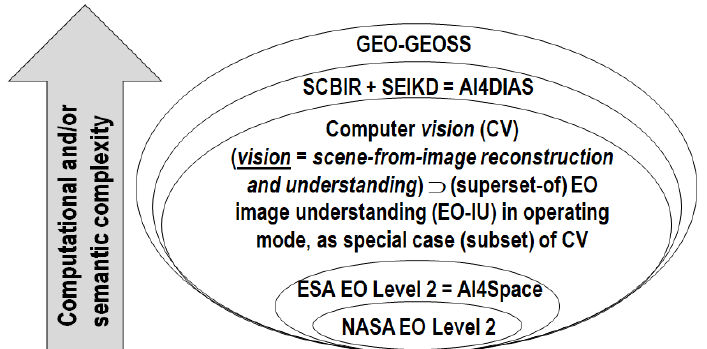
Figure 4. In agreement with the standard Unified Modeling Language (UML) for graphical modeling of object-oriented software [86], relationship part-of , denoted with symbol ‘ → ’ pointing from the supplier to the client, should not to be confused with relationship subset-of , ‘ ⊃ ’, meaning specialization with inheritance from the superset to the subset. A National Aeronautics and Space Administration (NASA) EO Level 2 product is defined as “a data-derived geophysical variable at the same resolution and location as Level 1 source data” [109]. Herein, it is considered part-of an ESA EO Level 2 product defined as [11,12]: (a) a single-date multi-spectral (MS) image whose digital numbers (DNs) are radiometrically corrected into surface reflectance (SURF) values for atmospheric, adjacency and topographic effects, stacked with (b) its data-derived general-purpose, user- and application-independent scene classification map (SCM), whose thematic map legend includes quality layers cloud and cloud–shadow. In this paper, ESA EO Level 2 product is regarded as an information primitive to be accomplished by Artificial Intelligence for the Space segment (AI4Space), such as in future intelligent small satellite constellations, rather than at the ground segment in an AI for Data and Information Access Services (AI4DIAS) framework. In this graphical representation, additional acronyms of interest are computer vision (CV), whose special case is EO image understanding (EO-IU) in operating mode, semantic content-based image retrieval (SCBIR) [13,110–115], semantics-enabled information/knowledge discovery (SEIKD), where SCIR + SEIKD is considered synonym